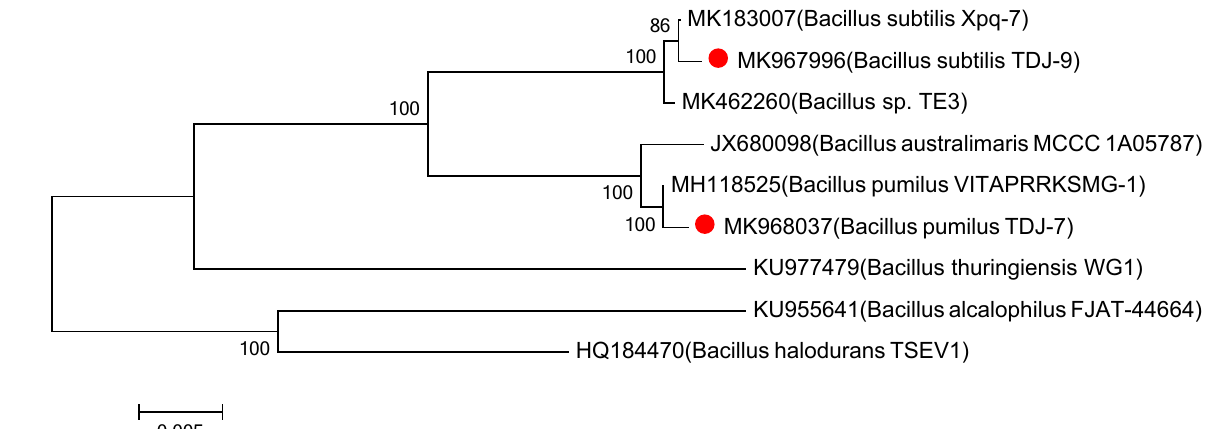
Figure 1. Phylogenetic tree of TDJ-7 and TDJ-9.